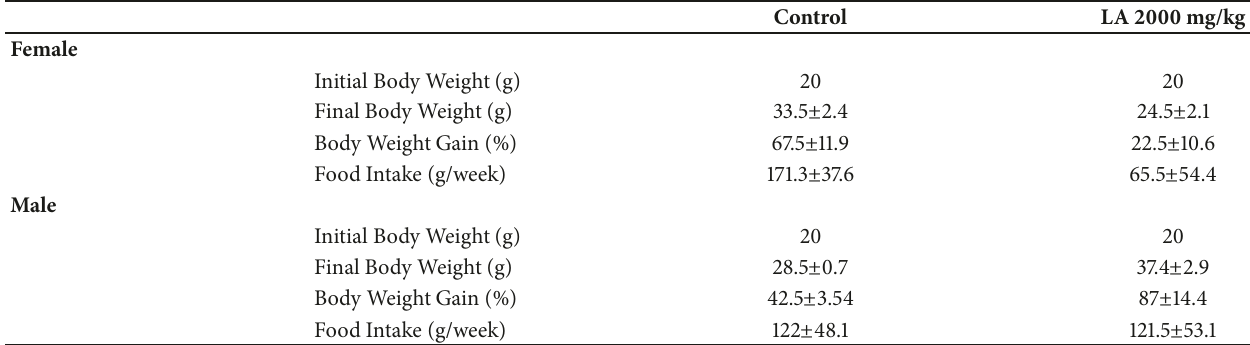
Table 4: Body weight and food consumption of mice orally treated with L. angustifolia EO for 21 days.